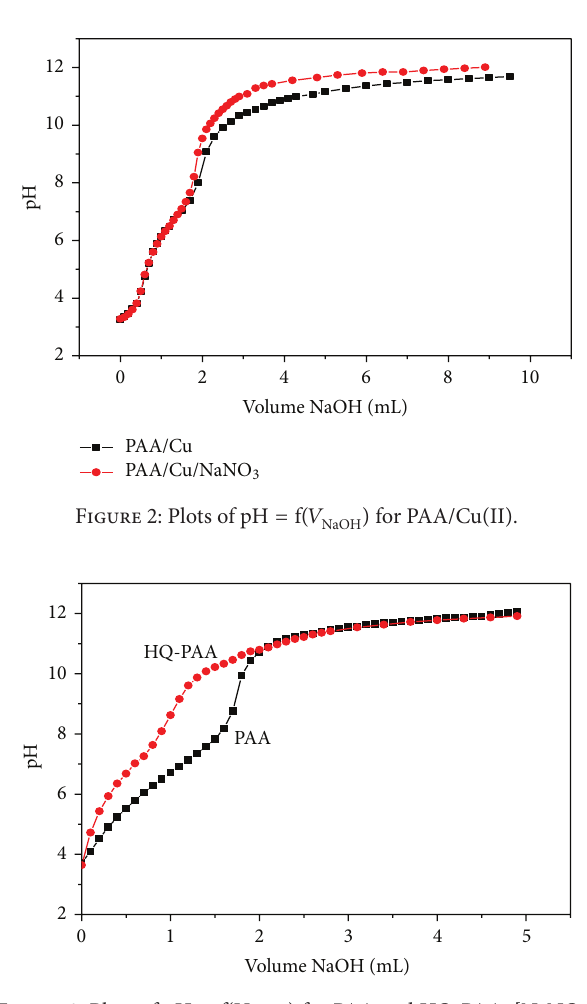
Figure 3: Plots of pH = f (𝑉 = 0.00 mol/L.